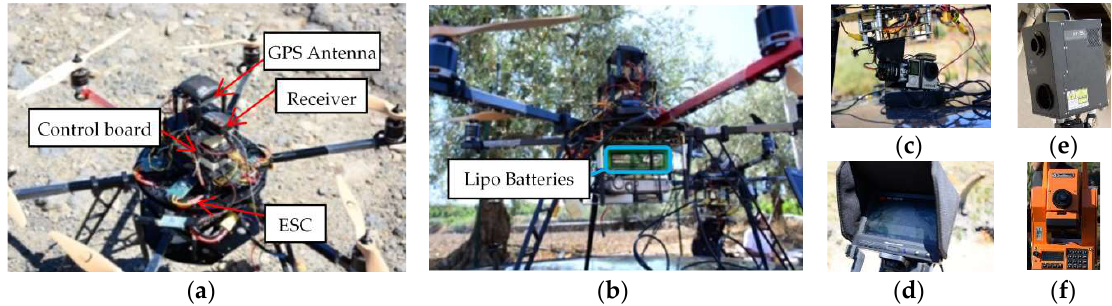
Figure 1. ( a ) UAV platform; ( b ) batteries and camera; ( c ) gimbal and camera; ( d ) LCD screen on the radio control; ( e ) laser scanner Konica Minolta 9v-I; ( f ) Geodimeter 480 total station-theodolites.